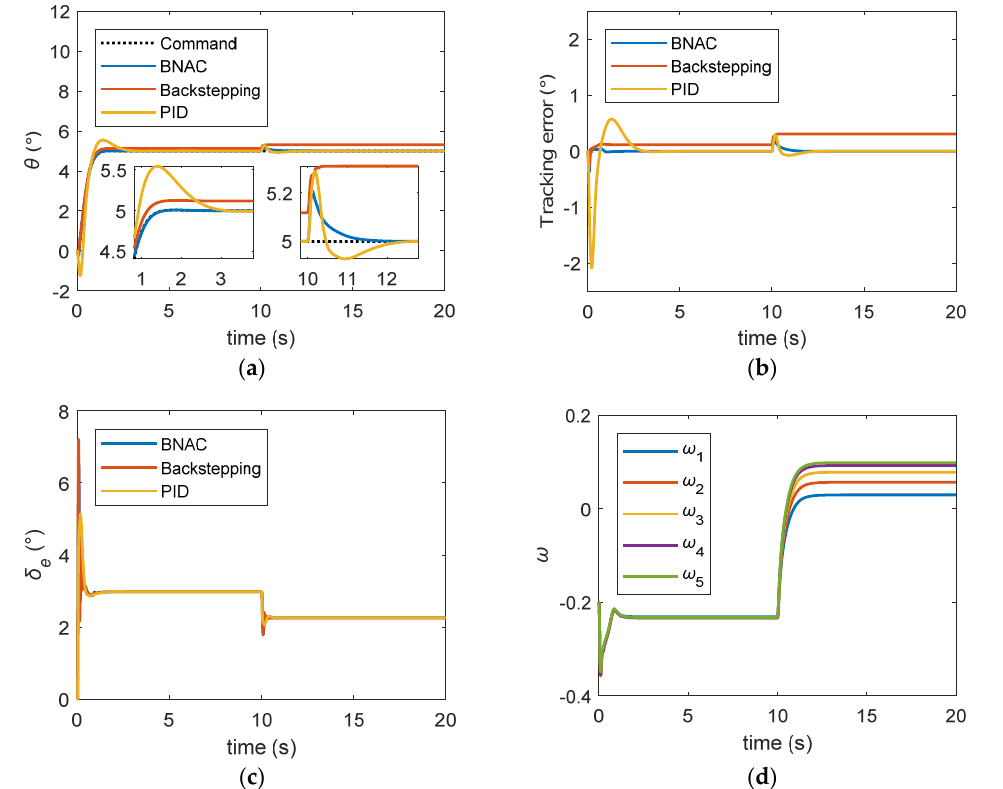
Figure 8. Step signal tracking results under external disturbance: ( a ) pitch angle trajectory; ( b ) tracking error; ( c ) elevator deflection; ( d ) RBF NN weights. BNAC: bio-inspired neural adaptive control. (BNAC: bio-inspired neural adaptive control, PID: proportion integration differentiation )